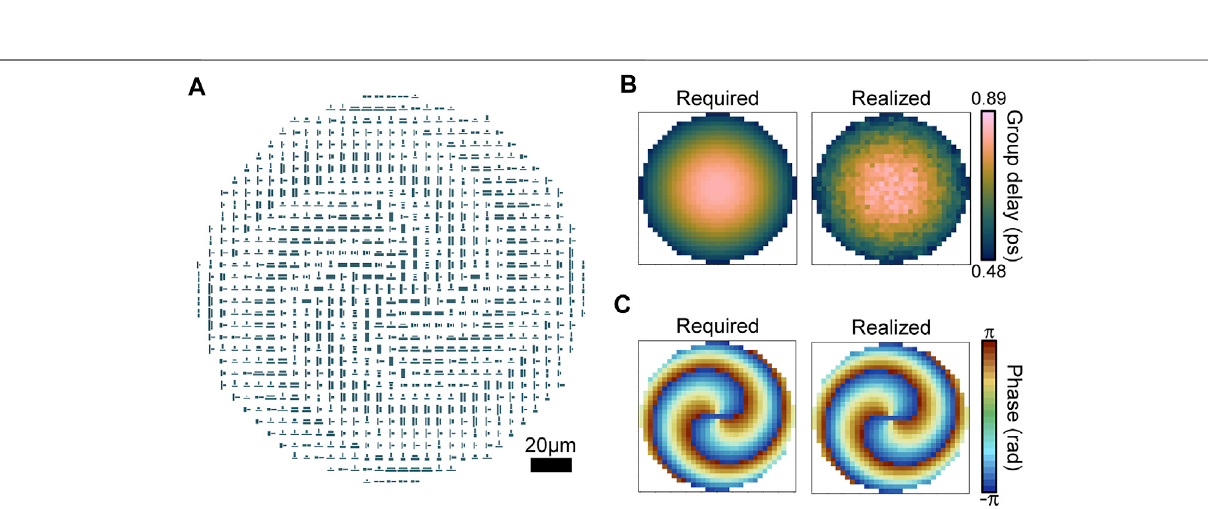
FIGURE5| Performancecharacterization ofthemetalens. (A) Relative focalshiftofthemetalens. (B) Ef fi ciencyofthemetalens. (C) Full-width-half-maximumofthe intensity at the focal plane. (D) Strehl ratio of the metalens. The black dashed lines in (C) and (D) represent the diffraction limit.